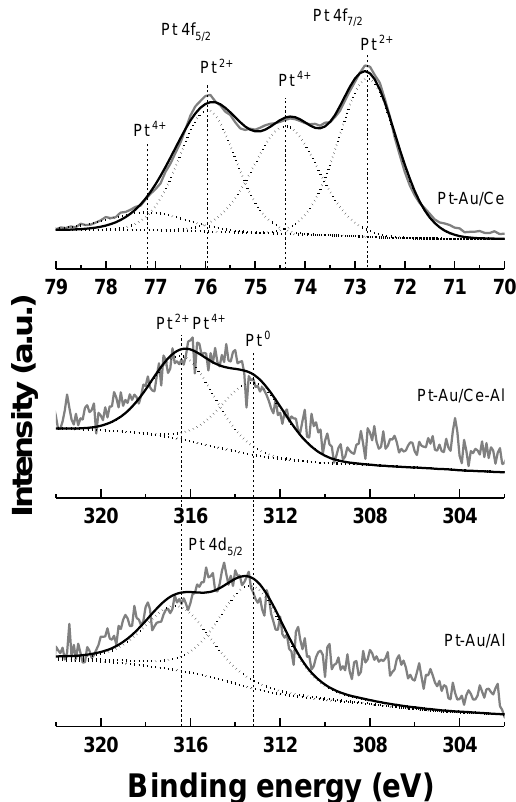
Figure 5. Pt 4f spectra of the Pt–Au / Ce catalyst and Pt 4d spectra of the Pt–Au / Ce–Al and Pt–Au / Al catalysts.